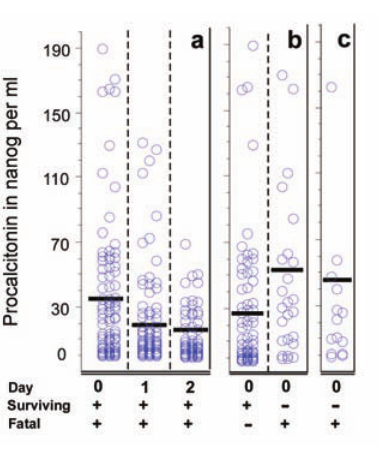
Figure 2. comparison of the distribution of PCT values in individuals from the 2 groups of patients. Scatter plot of the dis- tribution of procalcitonin levels in individ- uals with cerebral malaria a) on day 0 of hospitalisation and days 1 and 2 after entrance in intensive care service; b) on day 0 for surviving vs fatal cases; cc) patients deceased before day 2. Mean levels are plotted as thick